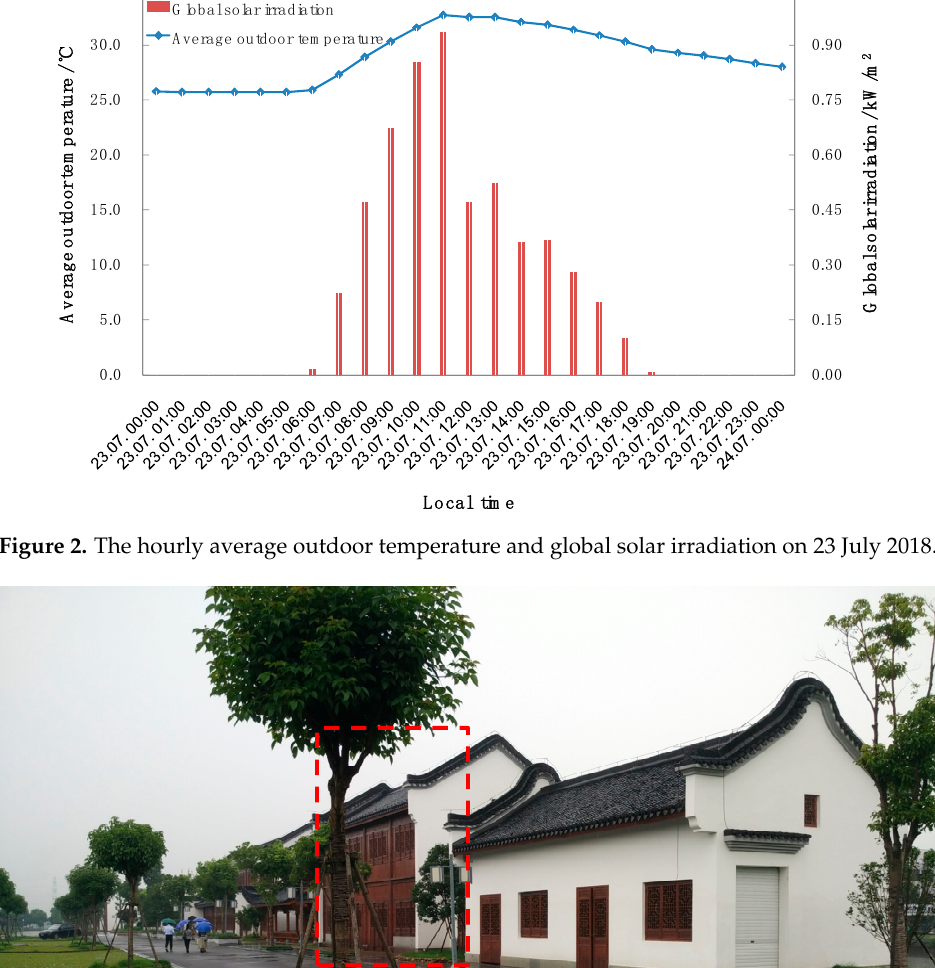
Figure 2. The hourly average outdoor temperature and global solar irradiation on 23 July 2018.